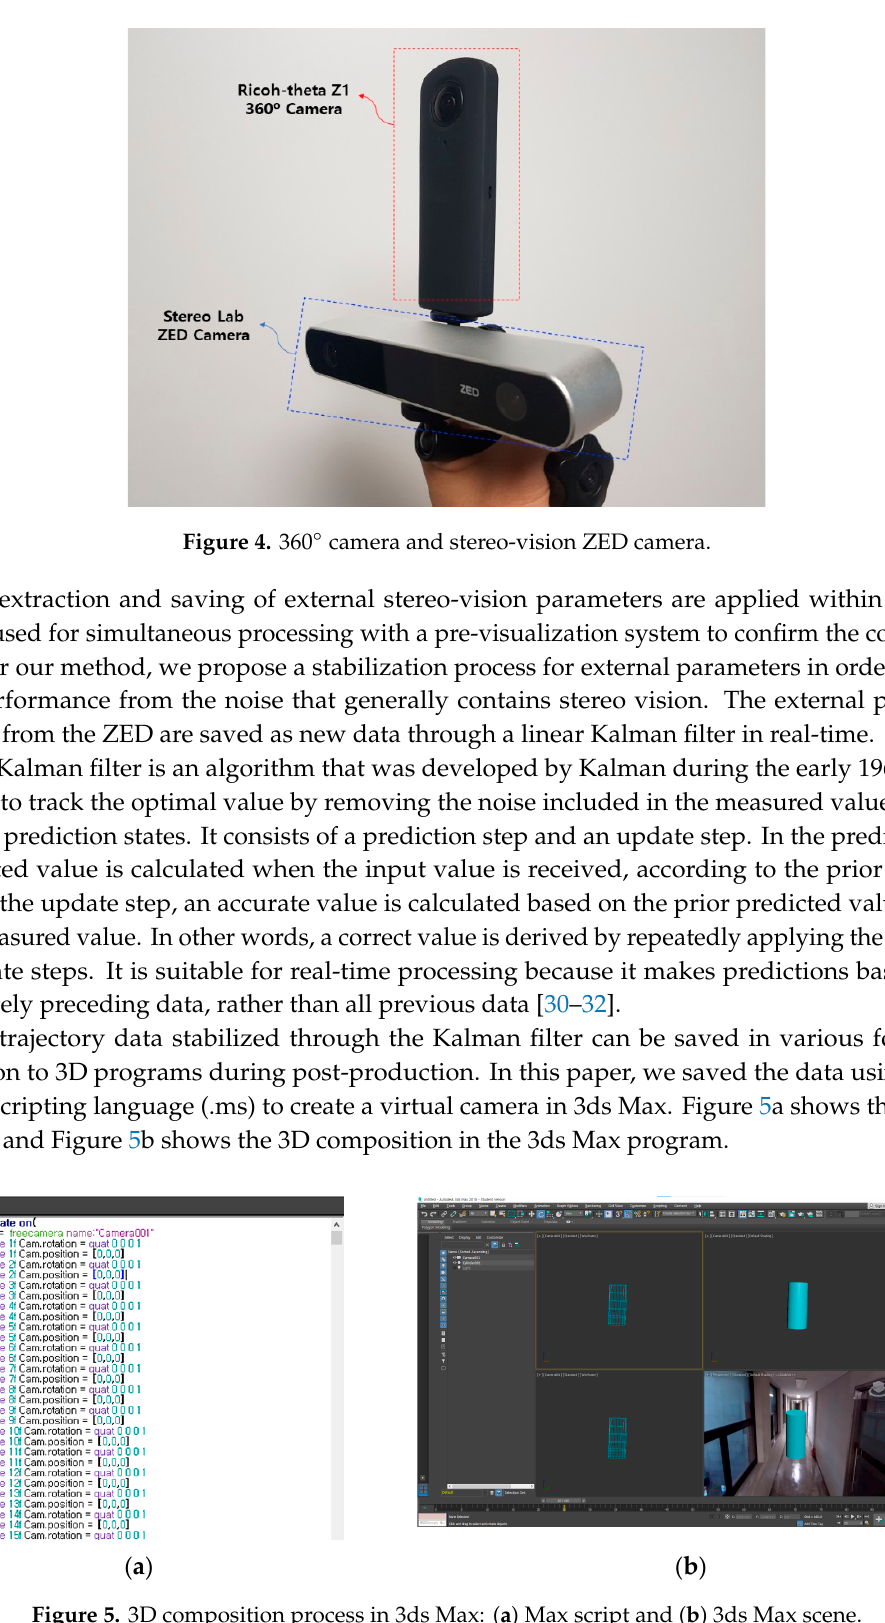
Figure 5. 3D composition process in 3ds Max: ( a ) Max script and ( b ) 3ds Max scene.